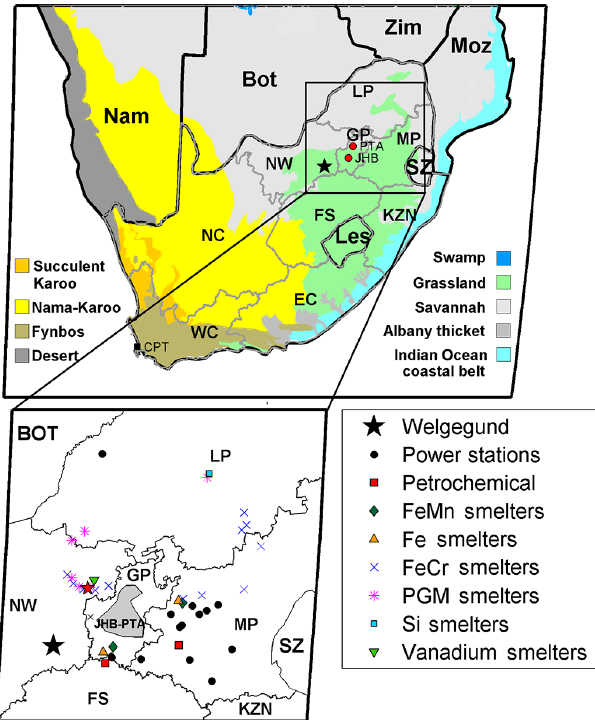
Figure 1. A bio-geographical map indicating Welgegund (black star), as well as the major point sources and the Johannesburg– Pretoria (JHB-PTA) conurbation. Neighbouring countries to South Africa (Nam: Namibia; Bot: Botswana; Zim: Zimbabwe; Mos: Mozambique; SZ: Swaziland; Les: Lesotho) as well as South African provinces (LP: Limpopo; NW: North West; FS: Free State; KZN: Kwa-Zulu Natal; MP: Mpumalanga; NC: Northern Cape; EC: Eastern Cape; WC: Western Cape) are also